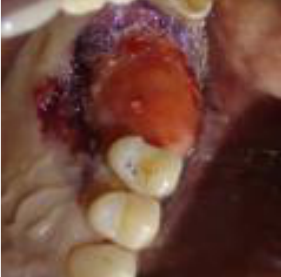
Figure 9. Detail of the application of the tissue glue to keep the tissues joined in situ.